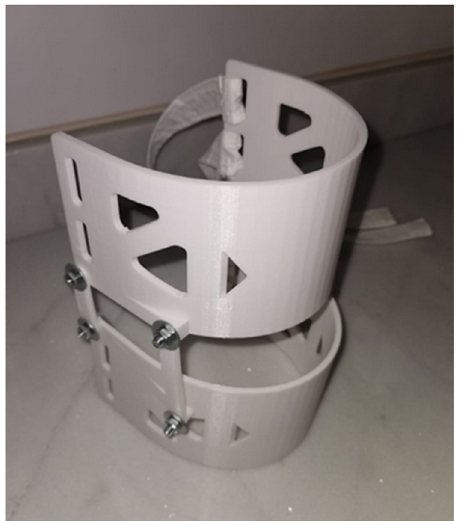
Figure 8: Prototype mechanism